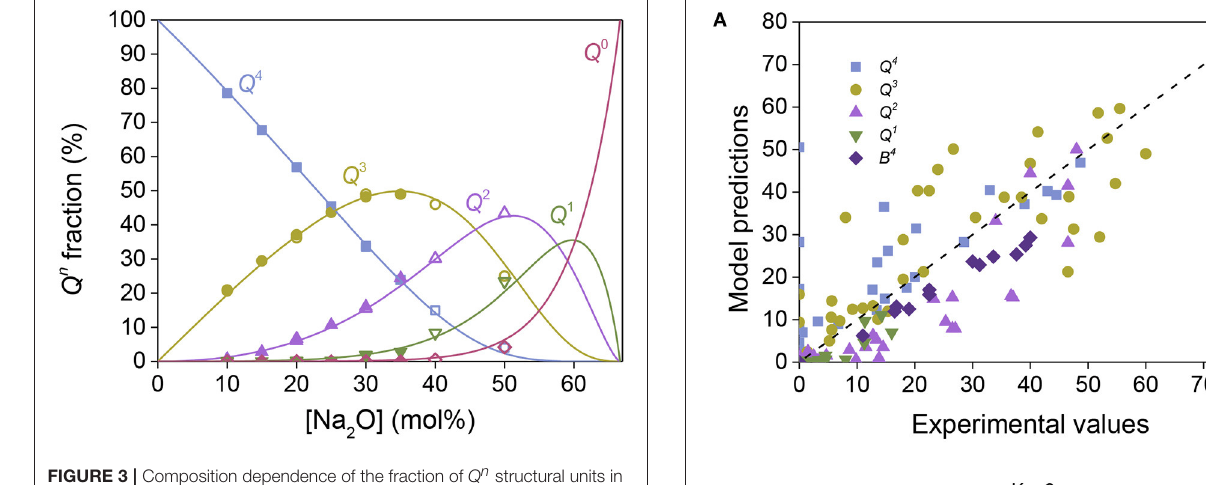
FIGURE 3 | Composition dependence of the fraction of Q n structural units in sodium silicate glasses. The closed and open symbols represent MD simulated data obtained by Du and Cormack (2004) and Adkins and Cormack (2011) , respectively. The solid lines represent model predictions, using the same bonding preferences parameter, but a different fictive temperature compared to Figure 1A .